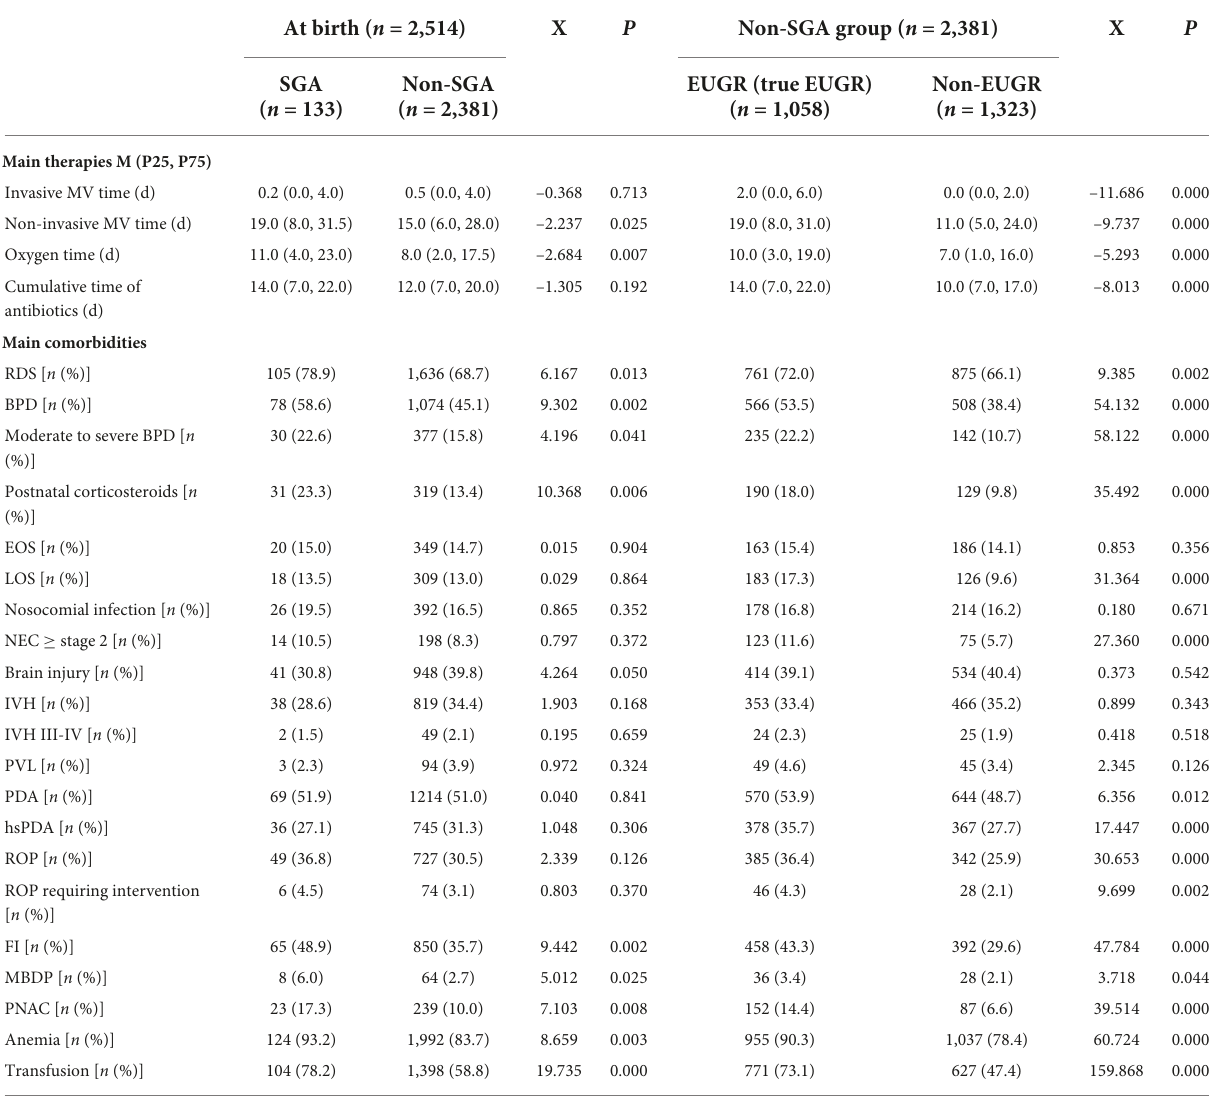
TABLE 4 Comparisons of therapies and complications between the groups.